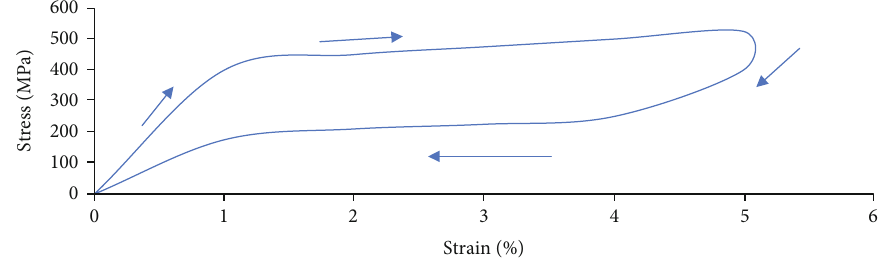
Figure 1: A stress-strain curve demonstrating the shape memory e ff ect of a titanium-nickel shape memory alloy